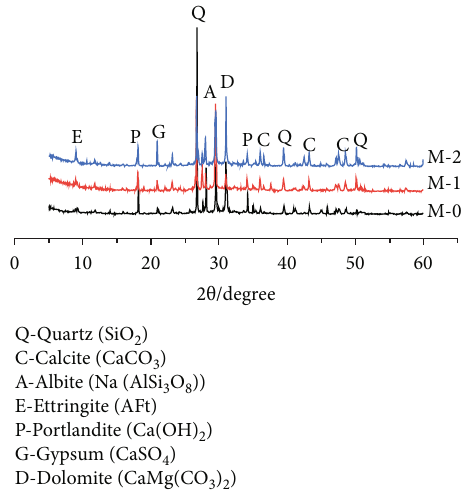
Figure 5: X-ray di ff raction analysis of steel slag concrete under sulfate attack (56